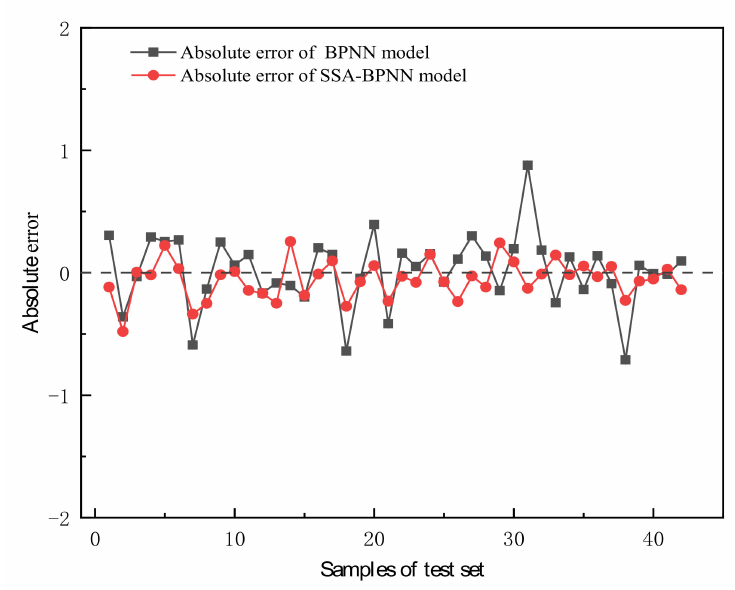
Figure 9. Absolute errors of BPNN and SSA-BPNN models.